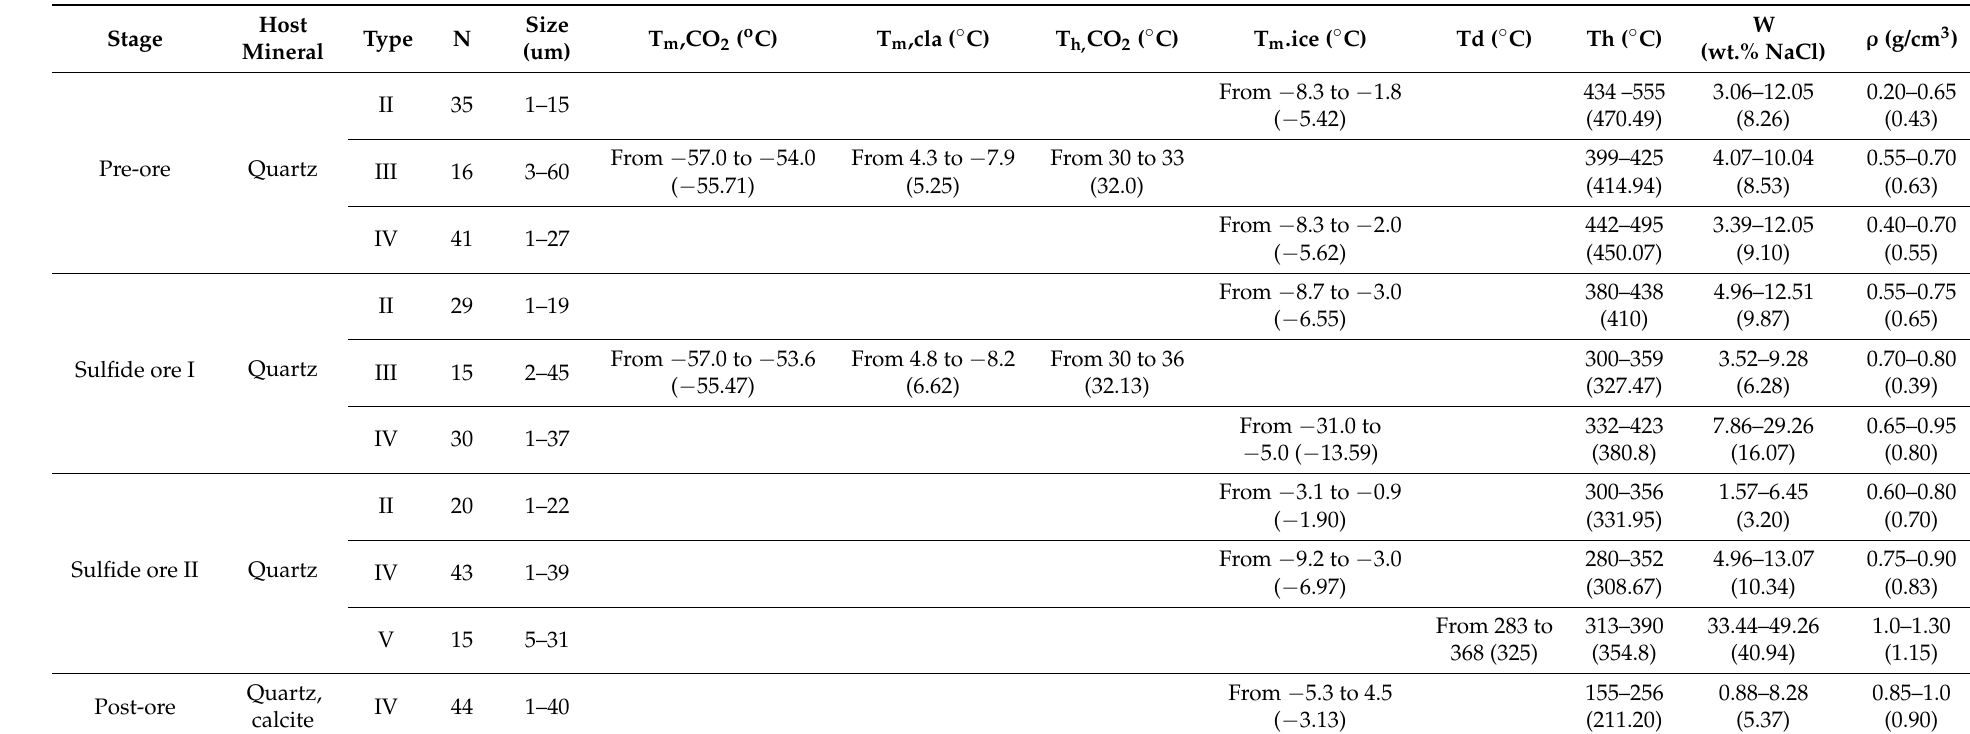
Table 4. Microthermometry data of the Kargah Cu-Pb polymetallic